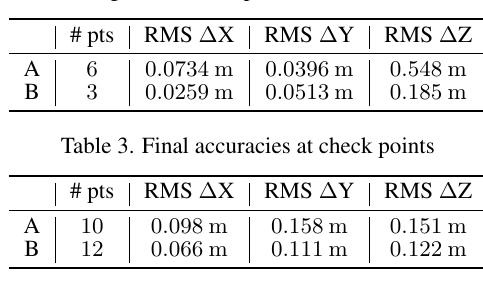
Table 4. Precision of SAR ground control and check points derived from SAR